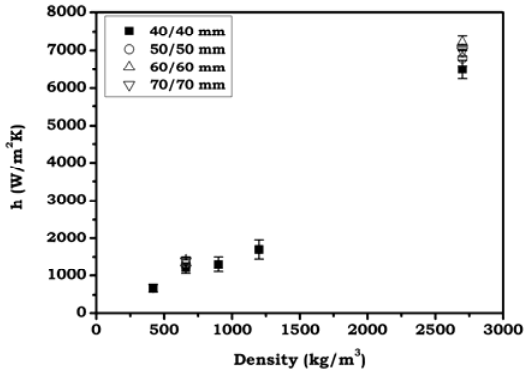
Figure 10. Predicted heat transfer coefficient obtained using the IHCP method over the experimental